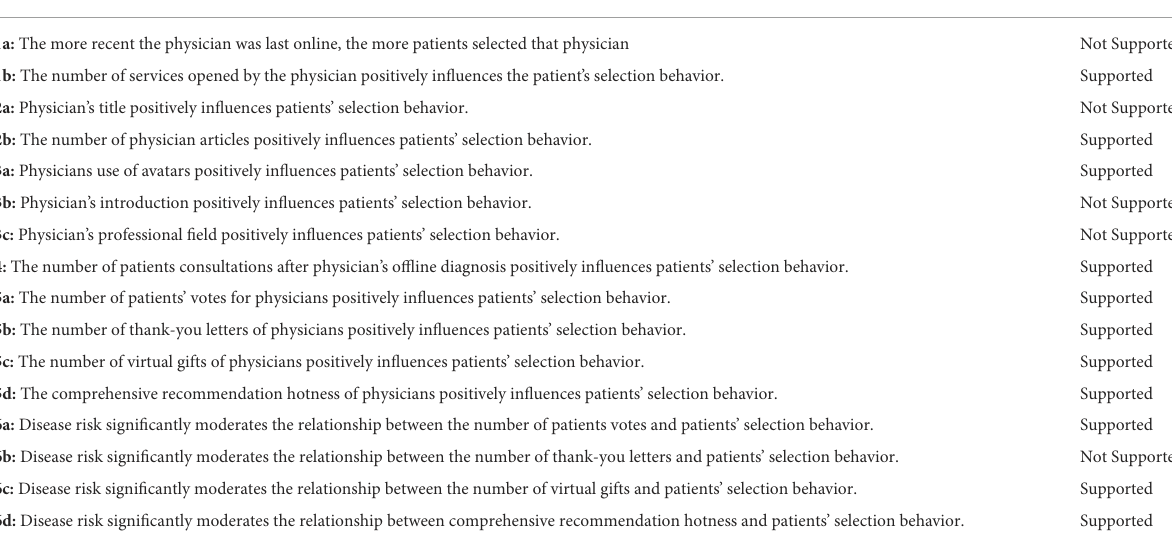
TABLE 6 Summary of